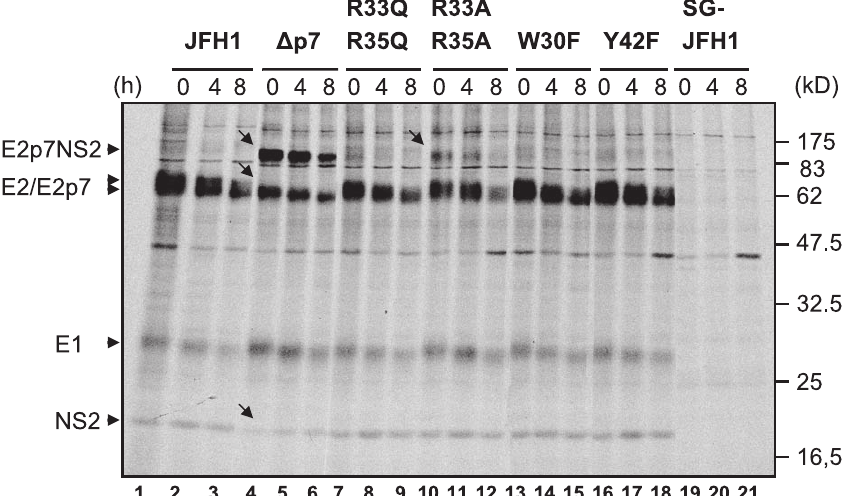
Figure 4. Processing of the E2-p7-NS2 Region of JFH1 and Various p7 Mutants Huh-7.5 cells were transfected with indicated constructs and after 24 h pulse-labeled with [35S] methionine/cysteine-containing medium, lysed immediately, or chased for 4 or 8 h. Cells transfected with a subgenomic JFH1 replicon encoding HCV proteins NS3–NS5B only (SG-JFH1) served as negative control. HCV proteins were immunoprecipitated using an antibody monospecific for E2 and are identified by arrows on the left. The positions of the molecular weight standard are given on the right. Arrowheads to the left point to the respective precursors and mature proteins detected. Arrows within the figure point out obvious alterations in protein processing.